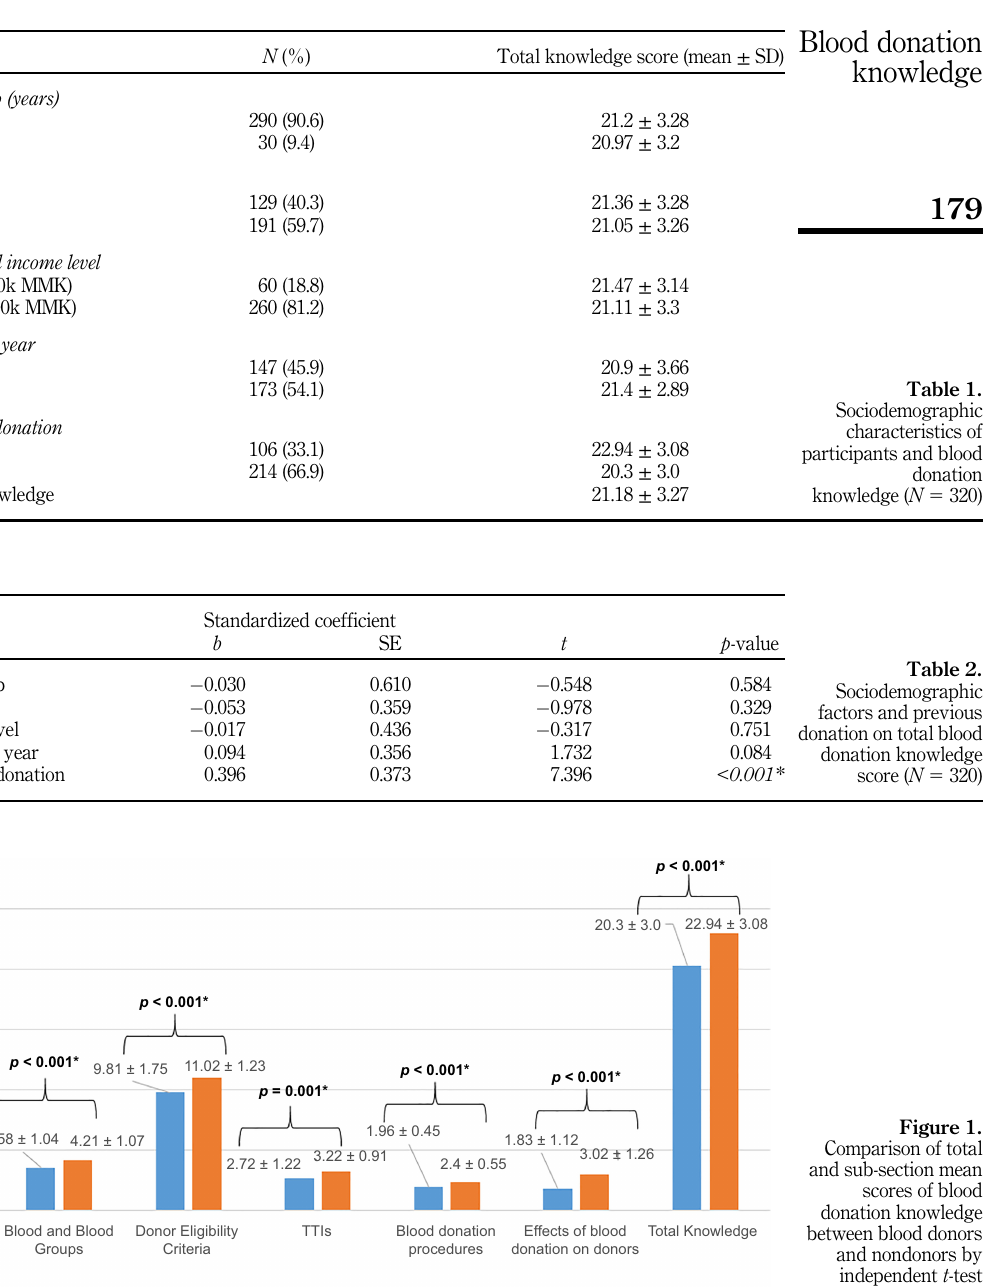
Figure 1. Comparison of total and sub-section mean scores of